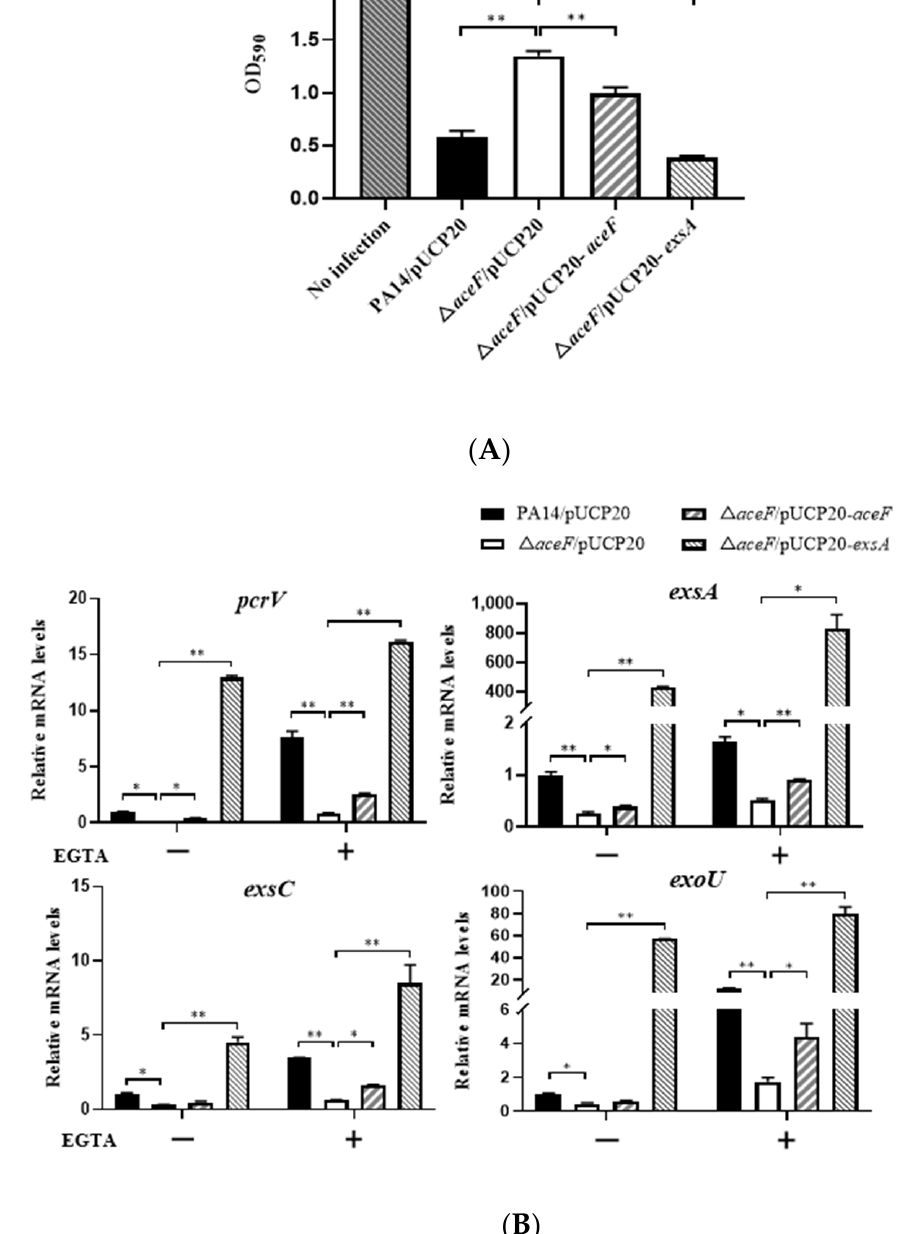
Figure 2. AceF influences the T3SS. ( A ) Cytotoxicity of wild-type PA14, the ∆ aceF mutant, and the mutant complemented with an aceF gene or overexpressing the exsA gene. A549 cells were infected with the bacteria for 3 h (MOI = 50). The cytotoxicity was determined by measuring crystal violet- stained cells. ( B ) mRNA levels of the T3SS genes. Bacteria were grown in the presence and absence of 5mM EGTA for 4 h. The relative mRNA levels of pcrV , exsA , exsC and exoU were determined by real-time PCR. Data shown represent mean ± standard error of mean from three samples. * p < 0.05; ** p < 0.01 by